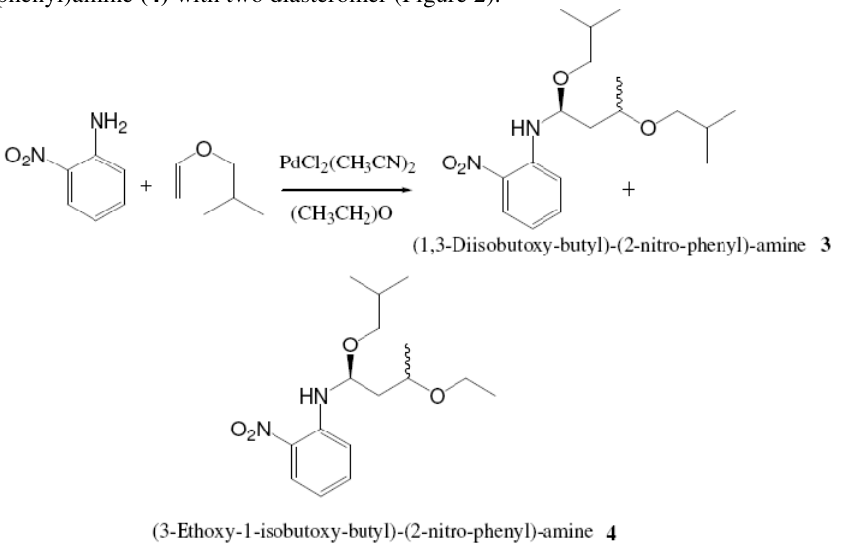
Figure 2. Reaction of 2-nitro aniline with isobutyl vinyl